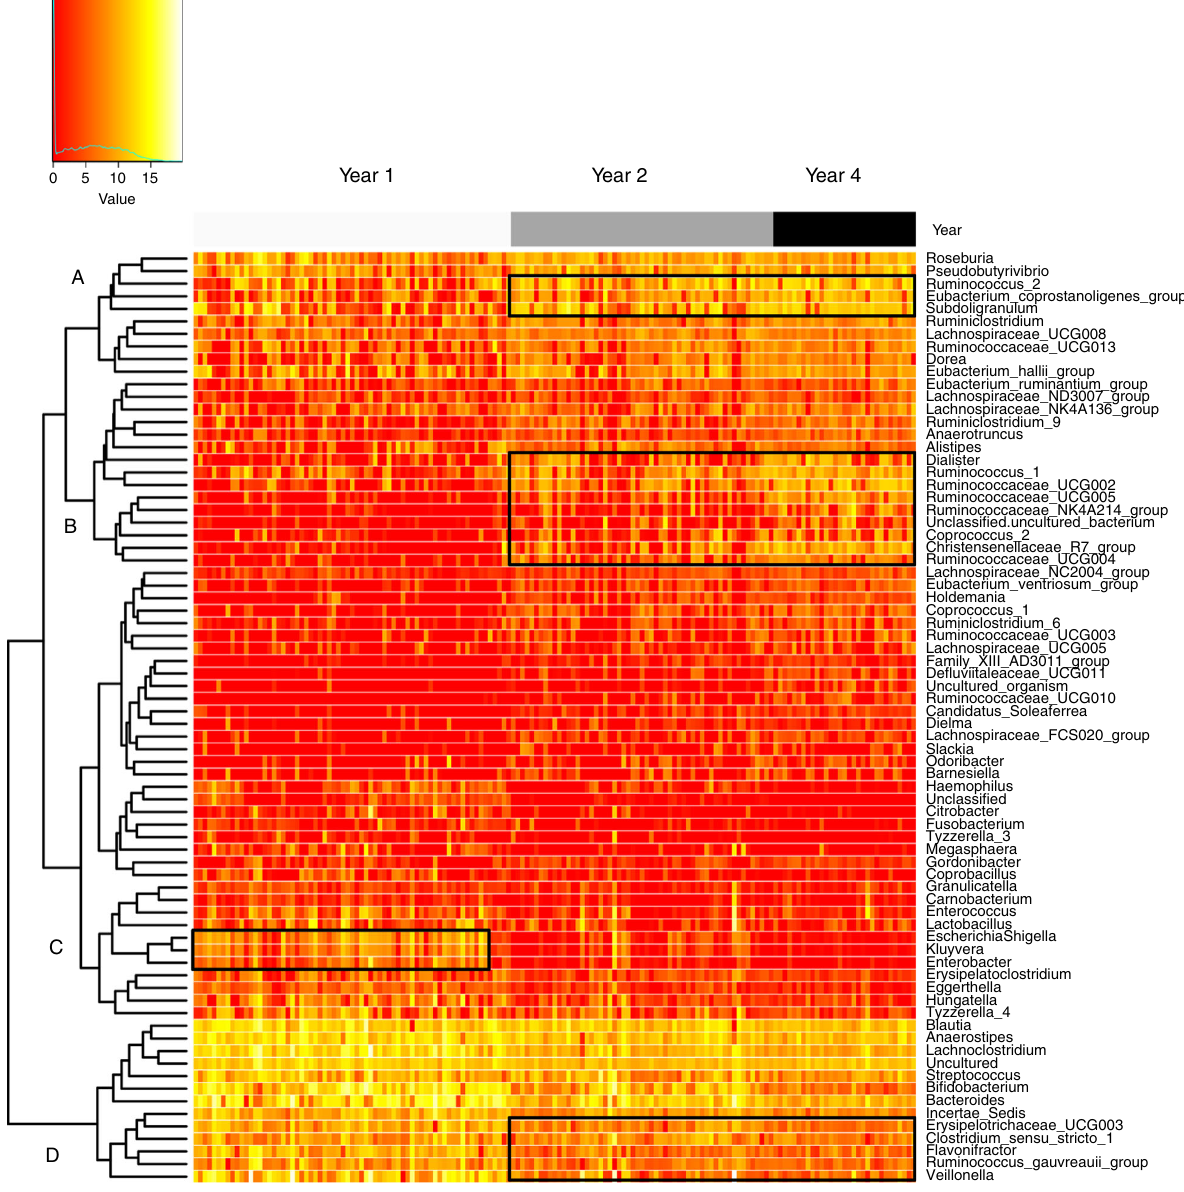
Fig. 5 Microbiota associated with the age of the infant. Heatmap based on top 100 genera clustered based on year. Values range from low (red) to high (yellow). Source data are provided as a Source Data fi